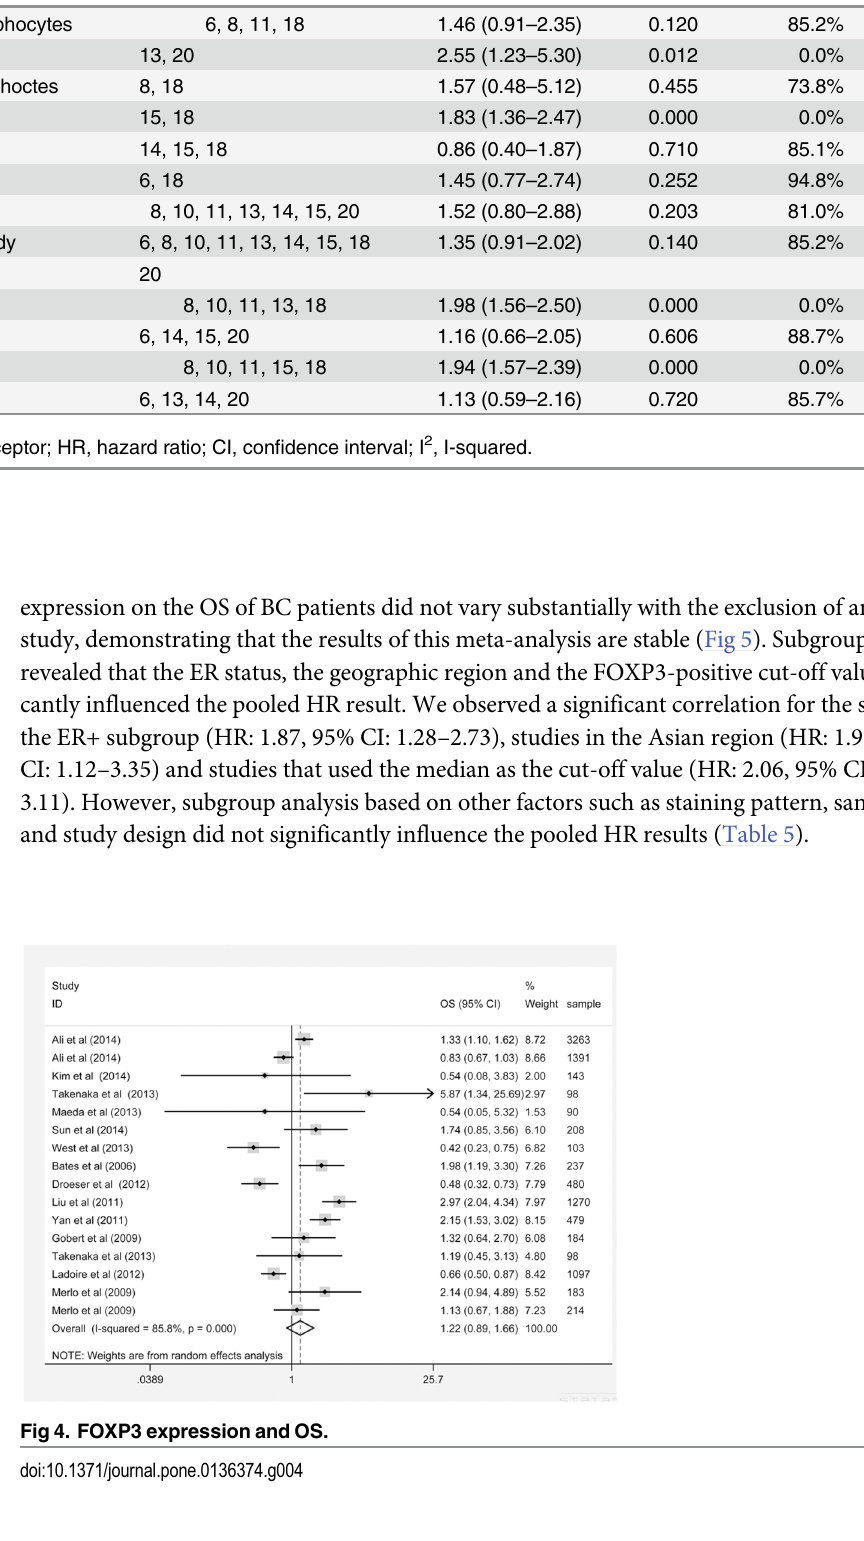
Table 4. Association between FOXP3 expression and DFS stratified according to FOXP3-positive region, ER status, sample size, study design, geographic region and the FOXP3-positive cut-off value. Strati fi ed analysis Ref. no.